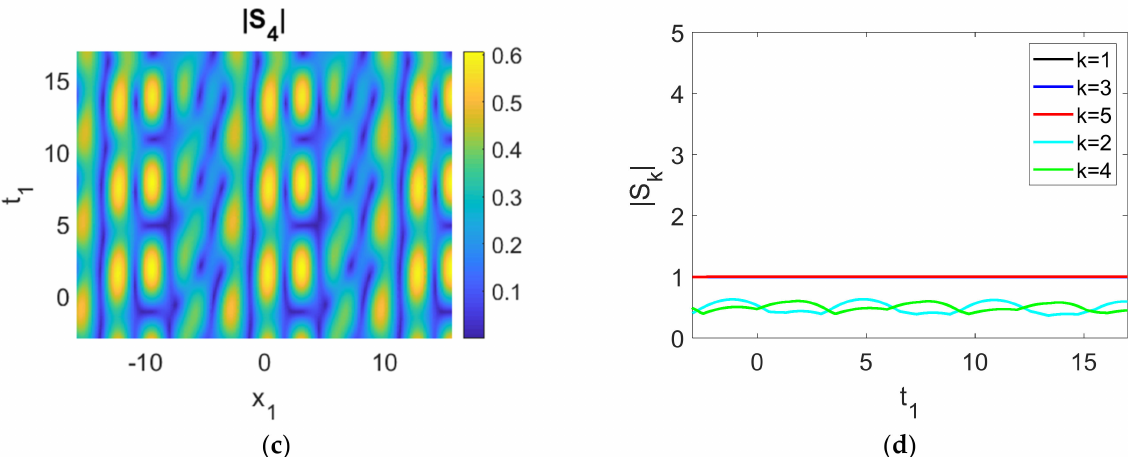
Figure 8. ( a – c ) Control experiment (only | S 2 |, | S 4 | and | S 5 | oscillate, | S 1 |, | S 3 | mostly unchanged); ( d ) time history of the moduli of the envelopes, | S k |. Parameters used were c g 1 = 2, c g 3 = 1, c g 5 = 0.5, c g 2 = − 0.1, c g 4 = 0.1, γ 1 = γ 3 = γ 5 a = 0, γ 2 = − 0.5, γ 4 = 0.5, − 0.01, a γ ρ ρ ρ ρ ρ δ = 2 = 1, 1 = 3 = 5 = 1, 2 = 4 = 0.1, 5 b =